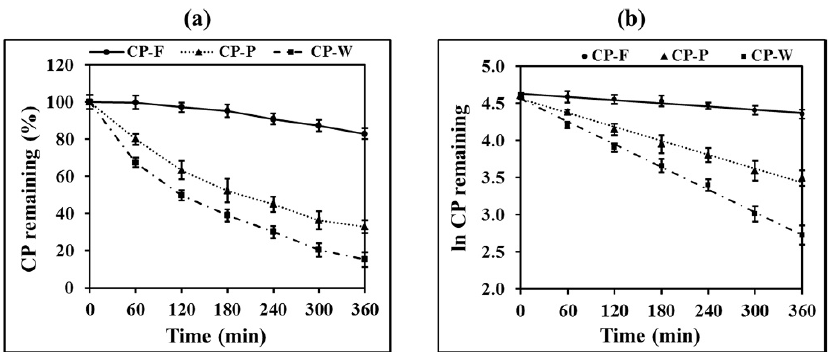
Figure 3. Degradation profiles of CP under UV light exposure, ( a ) zero order plots and ( b ) first order plots.